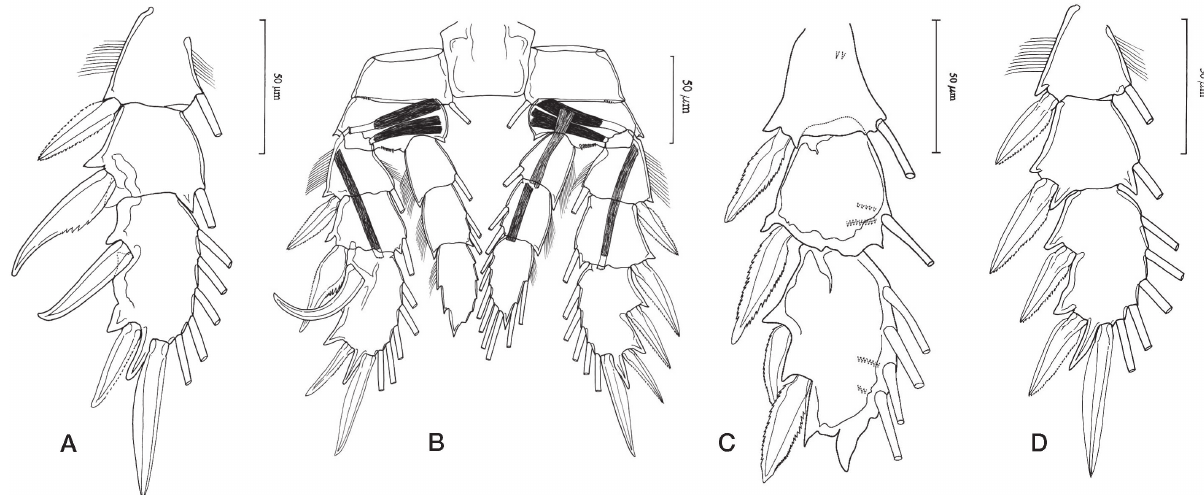
Fig . 3. – a, right exopod of leg 2 of male P. xiphophorus from lake faro showing modifications to second and third exopodal segments and their outer spines; anterior view. B, second leg pair of male P. xiphophorus from hong Kong (Bmnh reg. no. 1989.136) with highly modi- fied right exopod; anterior view, showing intrinsic musculature (endopodal muscles and endopodal setae omitted from right side). C, right exopod of leg 2 of paratype male of P. xiphophorus (Bmnh reg. no. 1967.8.4.2); anterior view showing unmodified outer margin spines and the presence of spinule rows on posterior surface (dotted) which indicates that isolated ramus is from right side. D, right exopod of leg 2 of male P. xiphophorus from lake faro – unmodified morphotype; anterior view.